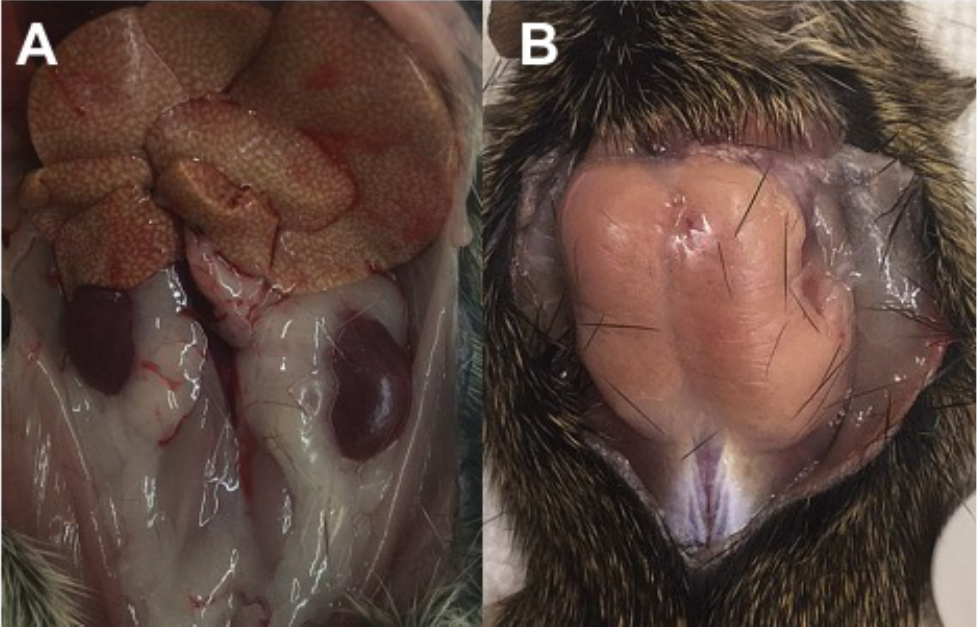
( B ) Interscapular BAT fat pads (10-week RBG =